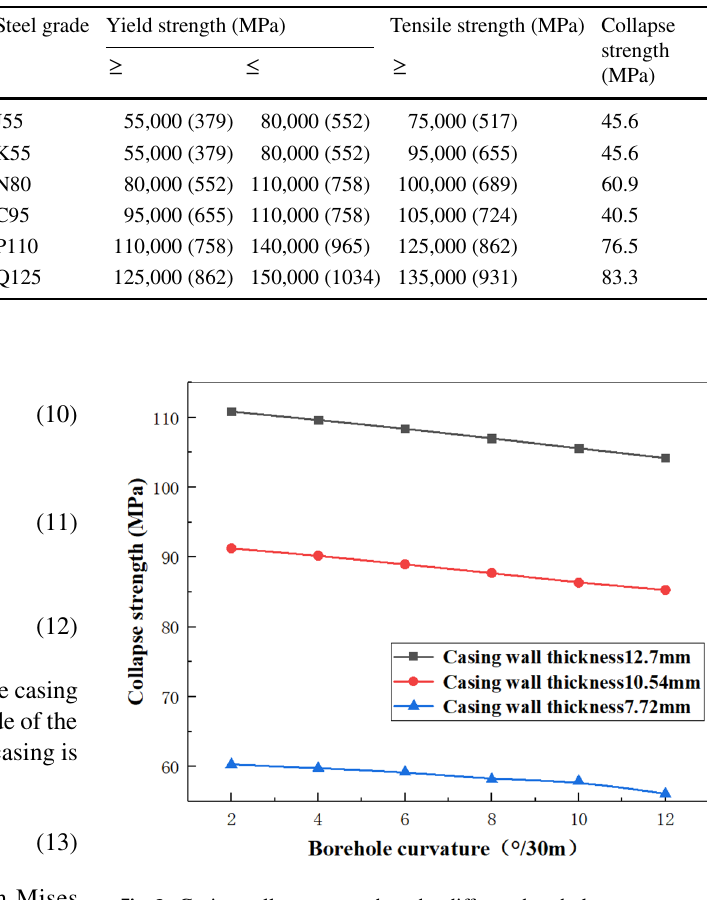
Fig. 2 Casing collapse strength under different borehole